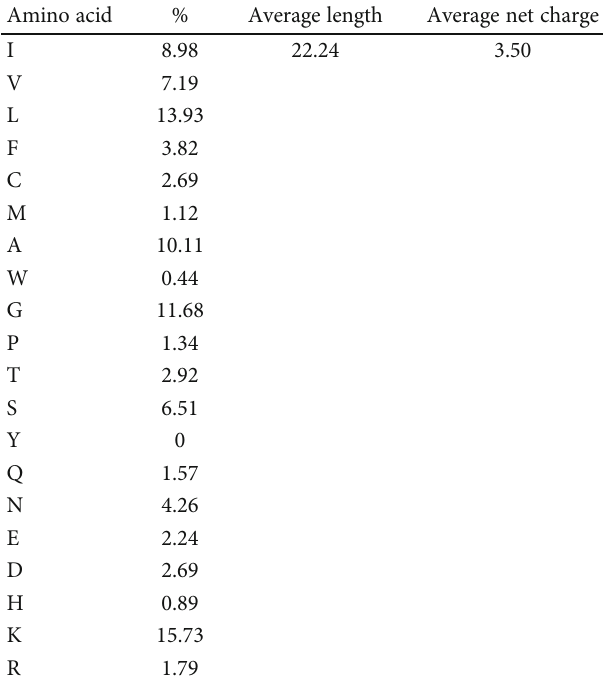
Table 2: The sequence information of reported antidiabetic